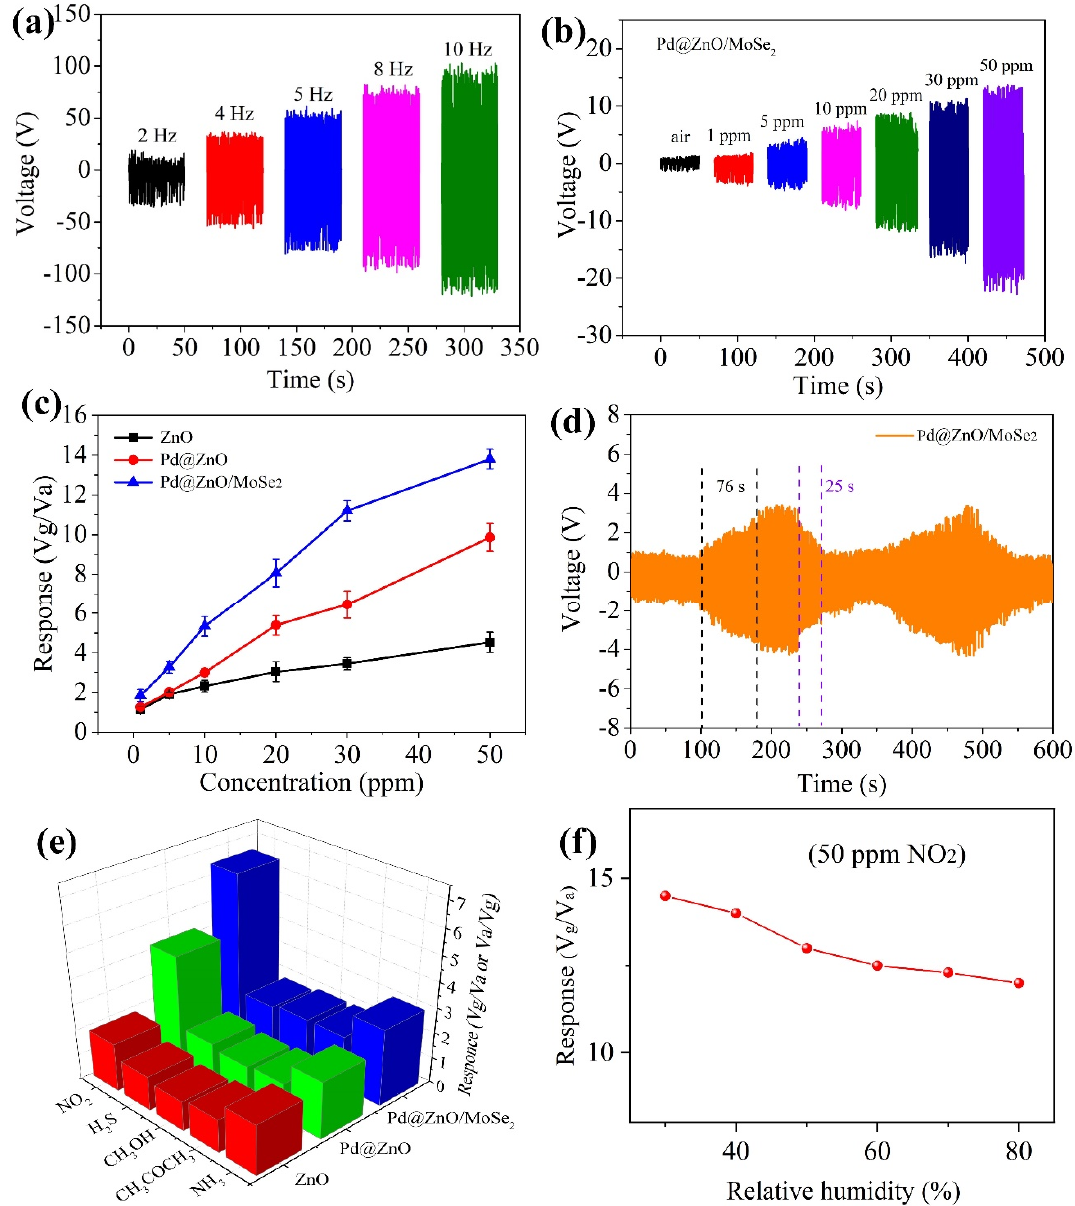
Figure 6. ( a ) Voltage test diagram of TENG at different frequencies at 25 °C. ( b ) Voltage values of